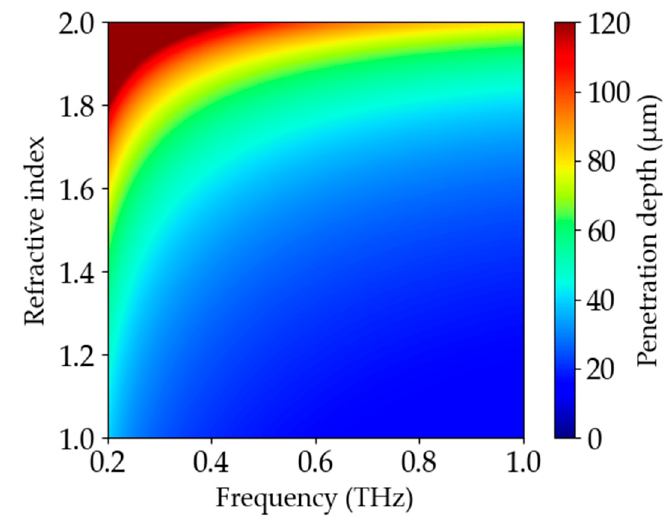
Figure 2. The penetration depth dependency on the frequency of THz wave and the refractive index of the sample. Here, a Silicon prism (n = 3.41) is used as a medium for total internal reflection.